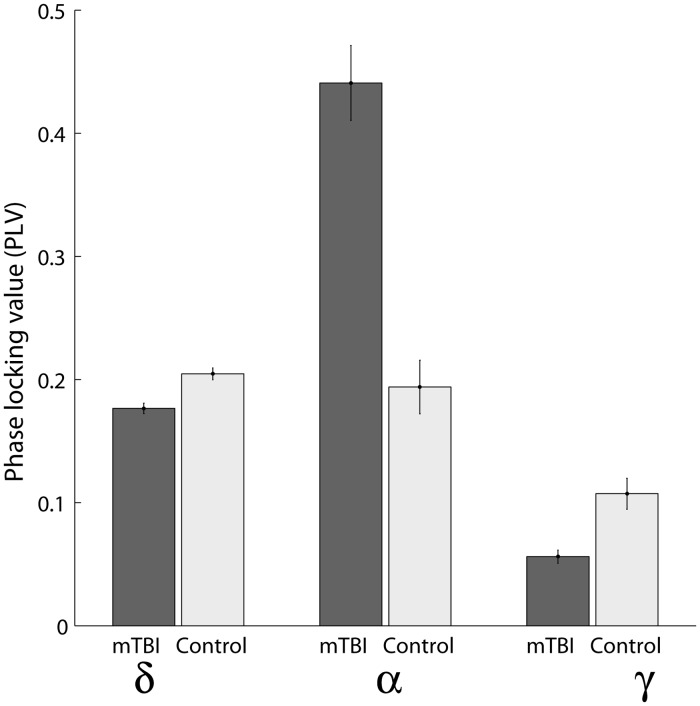
Phase-locking values for three specific connections at three characteristic frequencies.i) between the left middle occipital gyrus (Occipital Mid L) and the left median cingulate and paracingulate gyri (Cingulum Mid L) at 2 Hz; ii) between the temporal pole of the left middle temporal gyrus (Temporal Pole Mid L) and the left gyrus rectus (Rectus L) at 8 Hz; and iii) between the left inferior temporal gyrus (Temporal Inf R) and the right calcarine fissure and surrounding cortex (Calcarine R) at 75 Hz. Shown are the means across subjects and corresponding standard errors.